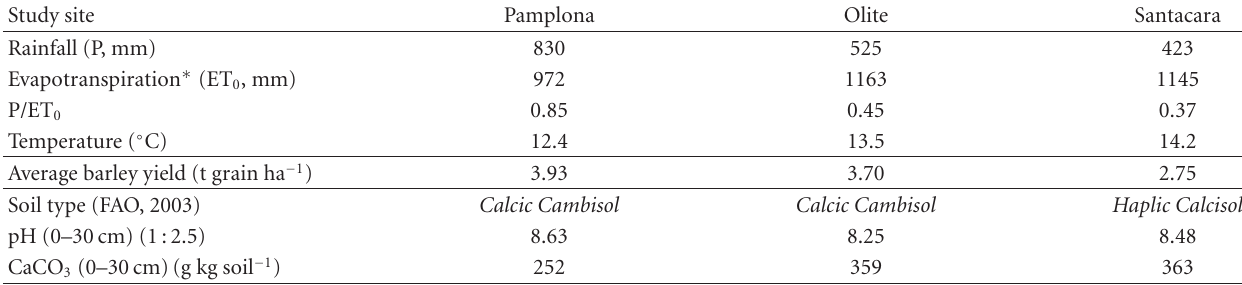
Table 1: Agroclimatic and soil characteristics of the three studied